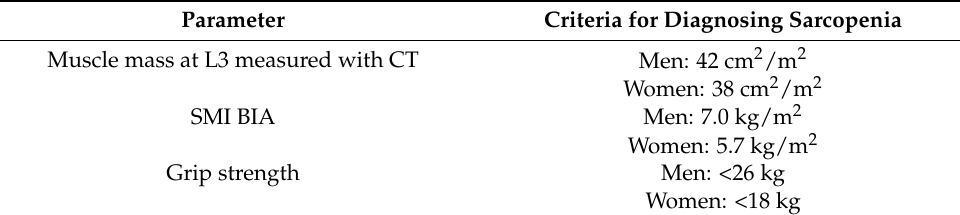
Table 2. Parameters and criteria for the diagnosis of sarcopenia. Parameter Criteria for Diagnosing Sarcopenia Muscle mass at L3 measured with